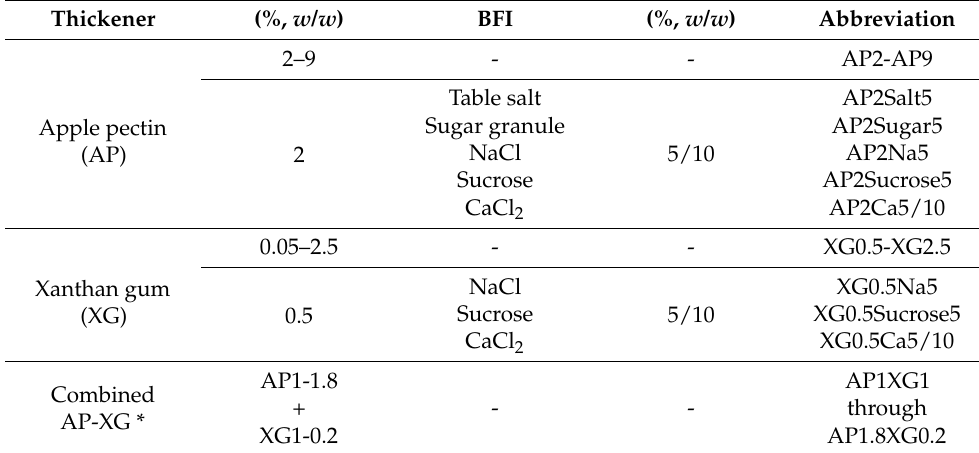
Table 1. Summary of the thickeners, sugars, and cations in terms of concentrations and abbreviation for dysphagia-friendly potential